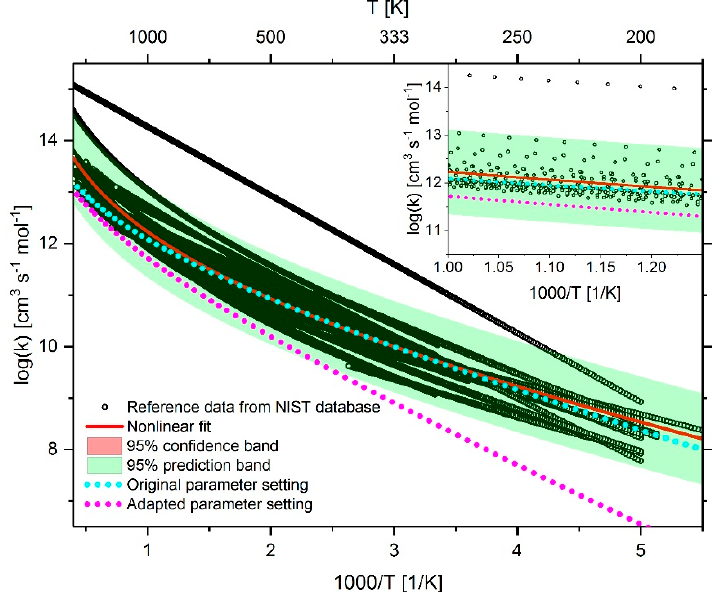
Figure 22. Comparison of the reaction rate coe ffi cient of reaction 42 (CH 4 + OH ↔ H 2 O + CH 3 ) before and after adaptation as well as the fitted rate coefficient using reference data from the NIST database.